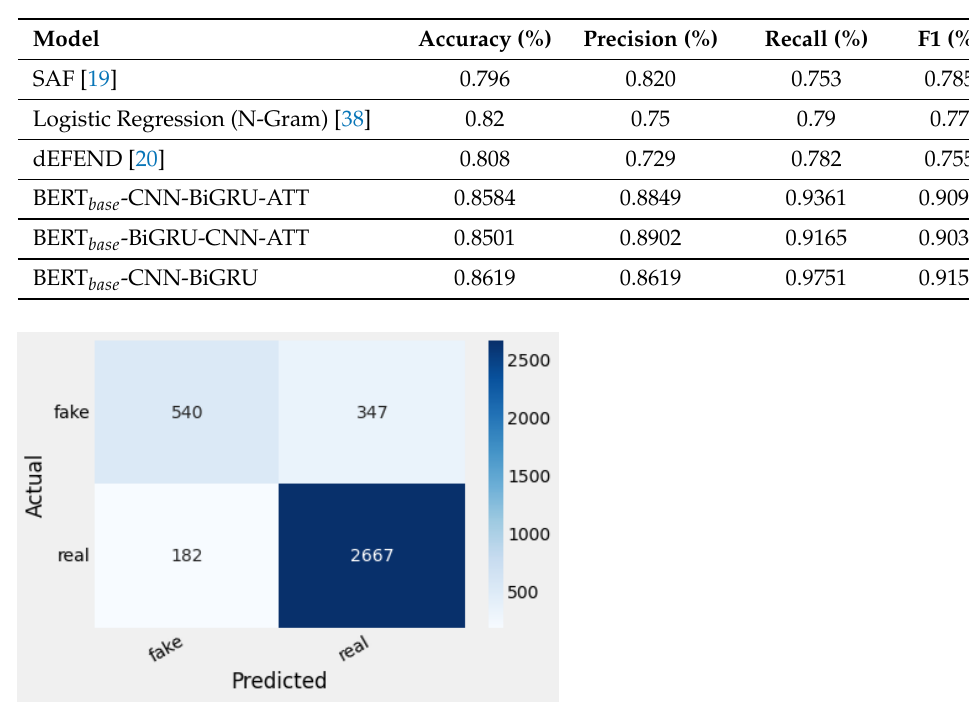
Table 5. Comparison (%) of the results obtained in the GossipCop dataset w/o user posting behavior features.